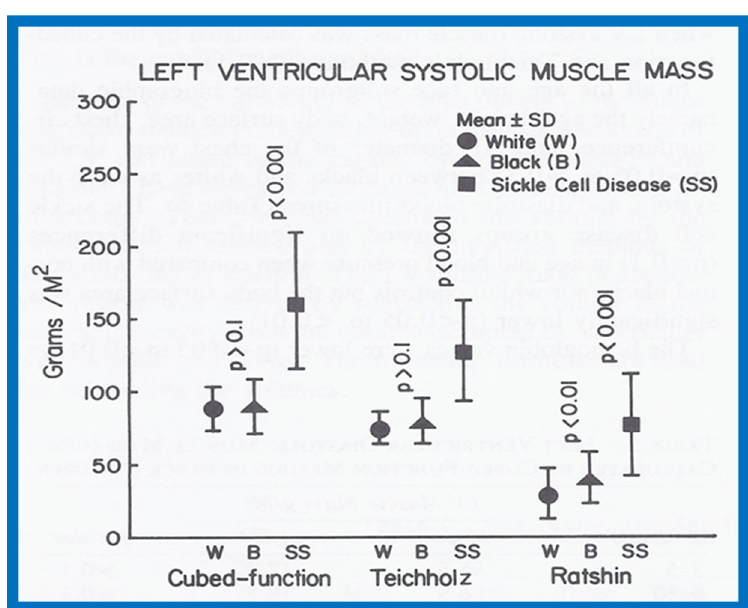
standard deviations are shown. Note higher muscle mass in black than in white children by cubed ‐ function ( p < 0.05) and Teichholz ( p < 0.01) methods; this difference is not significant ( p > 0.10 by Ratshin’s method. The diastolic left ventricular muscle mass in sickle cell disease is increased ( p < 0.001) when compared with normal subjects by all three methods. Reproduced from Rao P.S., et al. [9].